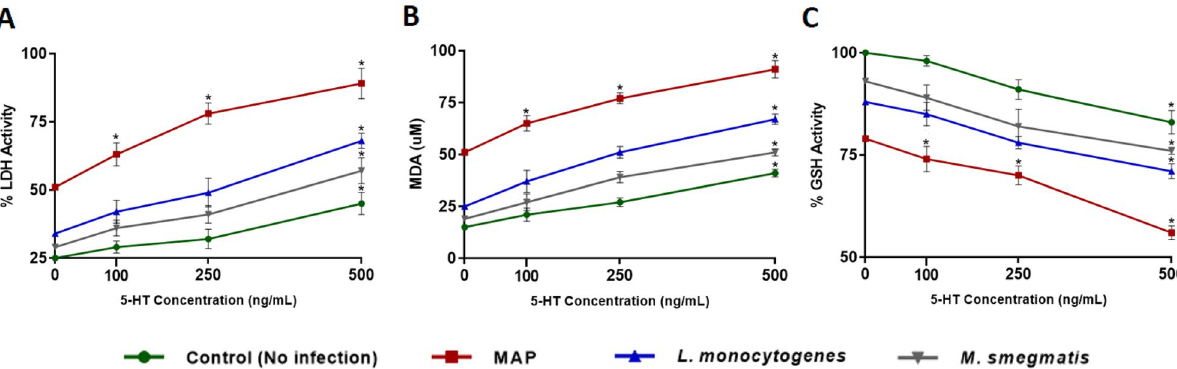
Figure 5. Effects of MAP, L. monocytogenes and M. smegmatis following 24 h of infection on LDH Activity ( A ) GSH Activity ( B ) and MDA level ( C ) in fully differentiated Caco-2 monolayers in the presence of different levels of 5-HT (0, 100, 250, and 500 ng/mL) following 24 h of incubation. LDH and GSH activity values are presented as percentage activity of control group without infection or 5-HT treatment. Values were pre-tested for normal distribution using the Kolmogorov–Smirnov normality test. Significance among experiments was assessed by repeated measures analysis of variance (ANOVA) followed by Bonferroni correction test. All LDH, GSH and MDA activity experiments were performed in triplicates. Data are presented as Mean ± SD. * P value < cells were exposed to 5-HT in a concentration dependent manner. Additionally, inhibition of SERT activity was accompanied with higher level of pro-inflammatory cytokines (TNF-α, IL-6, IL-8) and oxidative stress markers (LDH and MDA), whereas SERT expression and protein level were downregulated. These results indicate that TLR-2 activation may repress the intestinal SERT function and availability, leading to excessive accumulation of extracellular 5-HT in the GI tract. Consequently, inhibition of TLR-2 restored SERT activity and reduced the production of pro-inflammatory cytokines, which was reflected by the decrease in oxidative stress and tissue damage markers. Recently, it has been shown that 5-HT accumulation activates colonic nicotinamide adenine dinucleotide phosphate (NADPH) oxidase, which generates reactive oxygen species (ROS) 30 . Furthermore, we previously reported that MAP- infected CD patients had a higher level of glutathione peroxidase (GPx) activity, indicating higher oxidative stress level 31 . Therefore, accumulation of extracellular 5-HT in the presence of MAP infection further induced the pro-inflammatory process and caused higher level of tissue damage. Ultimately, this could affect the intestinal tight junctions that are essential in regulating the physical intestinal barrier, leading to paracellular movement of 5-HT across the intestinal epithelium to the blood vessels, where it can trigger complications in multiple organ-systems (Fig. 8). In order to investigate the underlying mechanism by which TLR-2 activation inhibits SERT activity, we used specific inhibitors of intracellular pathways involved in TLR-2 signaling. Recent studies have shown that cell signaling associated ERK pathway modulates TLR-2 signaling in macrophages and neuronal cells 32,33 . In addition, the cAMP/PKA pathway has been involved in the TLR-2 immune response 34 . However, we noticed that inhibition of the ERK and cAMP/PKA pathways did not have a significant effect on modulating pro-inflammatory cytokine release or restoring SERT activity. In contrast, inhibition of the p38 MAPK pathway had a significant effect on downregulating inflammation and restoring SERT activity. The results obtained have suggested that 5-HT progressively increases the phosphorylation of MAPK following MAP infection in a concentration dependent manner, which was demonstrated by increasing the ratio of p-p38 MAPK/p38 MAPK. The role of p38 MAPK signaling in modulating SERT function is controversial, since p38 MAPK activation does not have an effect on SERT activity in the brain, but it enhances SERT activity in neuronal cells 35,36 . Our results agree with two previous studies, showing that p38 MAPK activation inhibits SERT activity in the intestinal epithelial tissue 29,37 . The presence of 5-HT 3 receptors in the intestinal mucosa mediates a variety of GI processes, including motility and fluids secretion 5 . Therefore, 5-HT 3 antagonists effectively counteract chemotherapy ‐ induced emesis 6 . Since 5-HT 3 receptors are expressed in macrophages and T-cells, new reports have shed light on additional potential anti-inflammatory applications for this class of drugs, which confirms the role of these receptors in inflammatory and immune responses 8,9 . In this study, we blocked 5-HT 3 receptors by using ondansetron, which significantly suppressed MAP-induced inflammation and mitigated the effects of had a significant effect of excess 5-HT exposure. Furthermore, this treatment significantly restored SERT expression and function. Collectively, these results indicate that using 5-HT 3 receptor antagonists may have a potential role in suppressing the intestinal inflammatory response to pathogenic bacteria. It is worth mentioning that higher SERT expression was found in the human small intestine compared with the colon 38 . Interestingly, SERT expression demonstrates remarkable variation across different regions of the human small intestine, with highest expression in the ileum, followed by the duodenum and the jejunum 38 . Low SERT expression in the colon may point out an alternate mechanism for 5-HT uptake by different monoamine transporters, including norepinephrine transporter (NET), organic cation transporter (OCT), and dopamine transporter (DAT) 38 . Whether the accumulation of 5-HT in the colonic mucosa induces expression of SERT or other monoamine transporters in the colonic epithelial cells, needs further investigation.